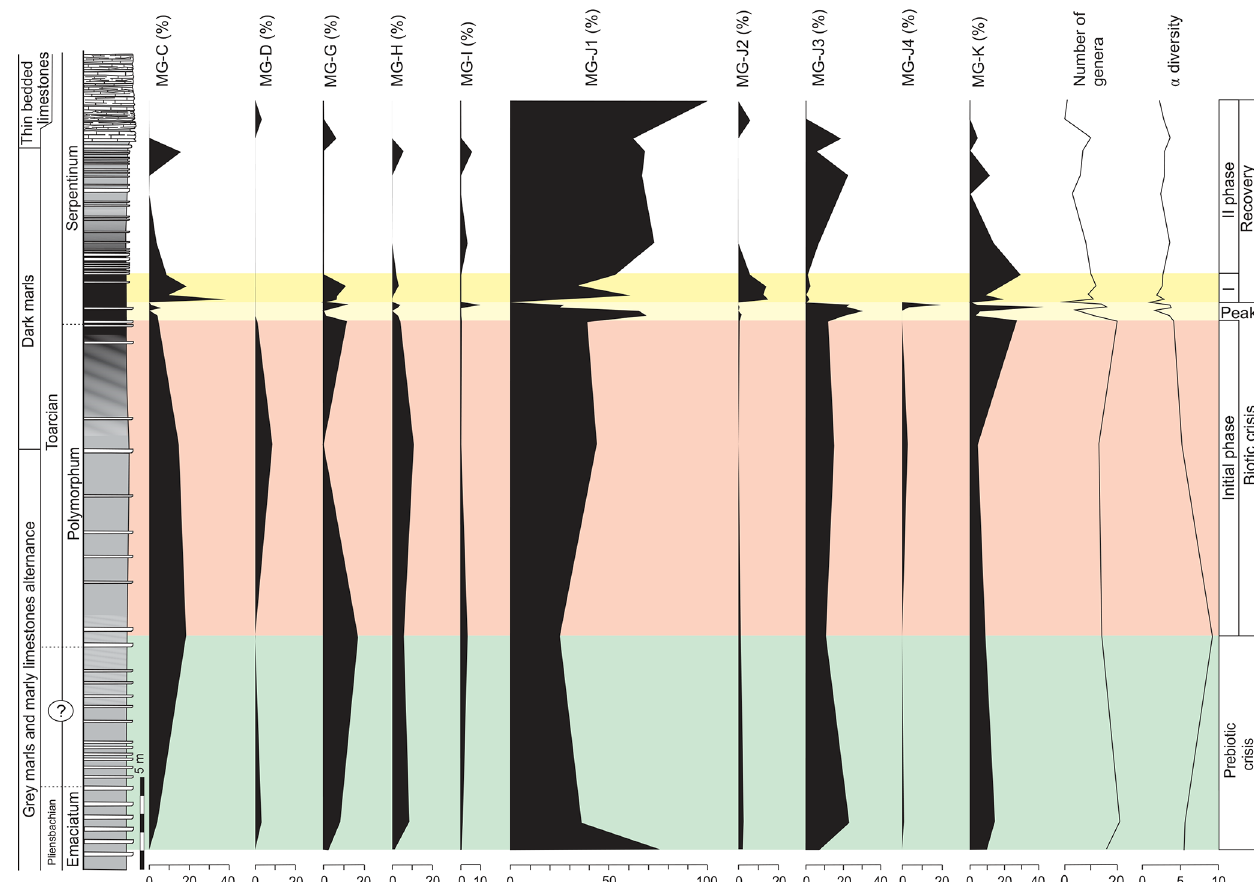
Figure 7. Stratigraphic distribution of the proportions of foraminiferal morphogroups and diversity (number of genera and α diversity).